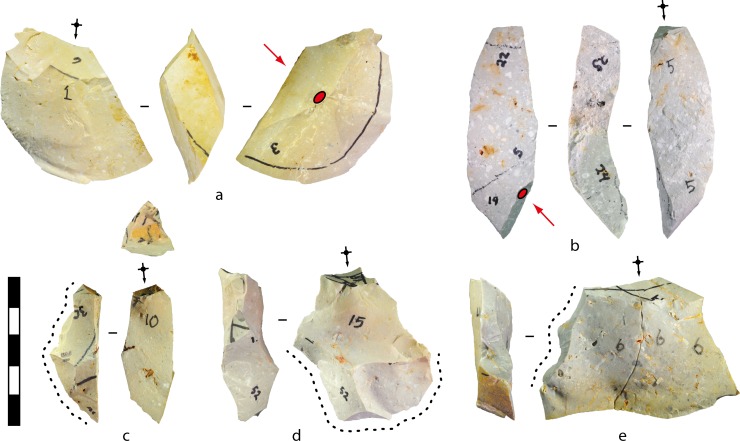
Flake types produced in the experiments.(A-B) Contact removal (‘Kombewa’) flakes produced in the flake blank experiments. The red arrows and dots mark the percussion axes and points of force application for detaching the flake blanks, and the black diacritical arrows show the platform location and percussion axes for the contact removal flakes. Flake B was struck burin-like down the edge of the flake blank. (A) Silcrete, experiment 4, blow 1. (B) Silcrete, experiment 25, blow 5. (C-E) Redirecting flakes produced in the flake blank experiments. The black diacritical arrows show the platform locations and percussion axes, and the dotted lines mark the part of the core platforms removed by the flakes. C was struck burin-like directly down the edge of the flake blank, D overstruck the end of the bifacial core, and E spread laterally in a tranchet-like fashion and removed part of the core’s margin. E was broken by a siret fracture. (C) Silcrete, experiment 12, blow 10. (D) Silcrete, experiment 3, blow 15. (E) Silcrete, experiment 27, blow 6. Scale 50 mm.